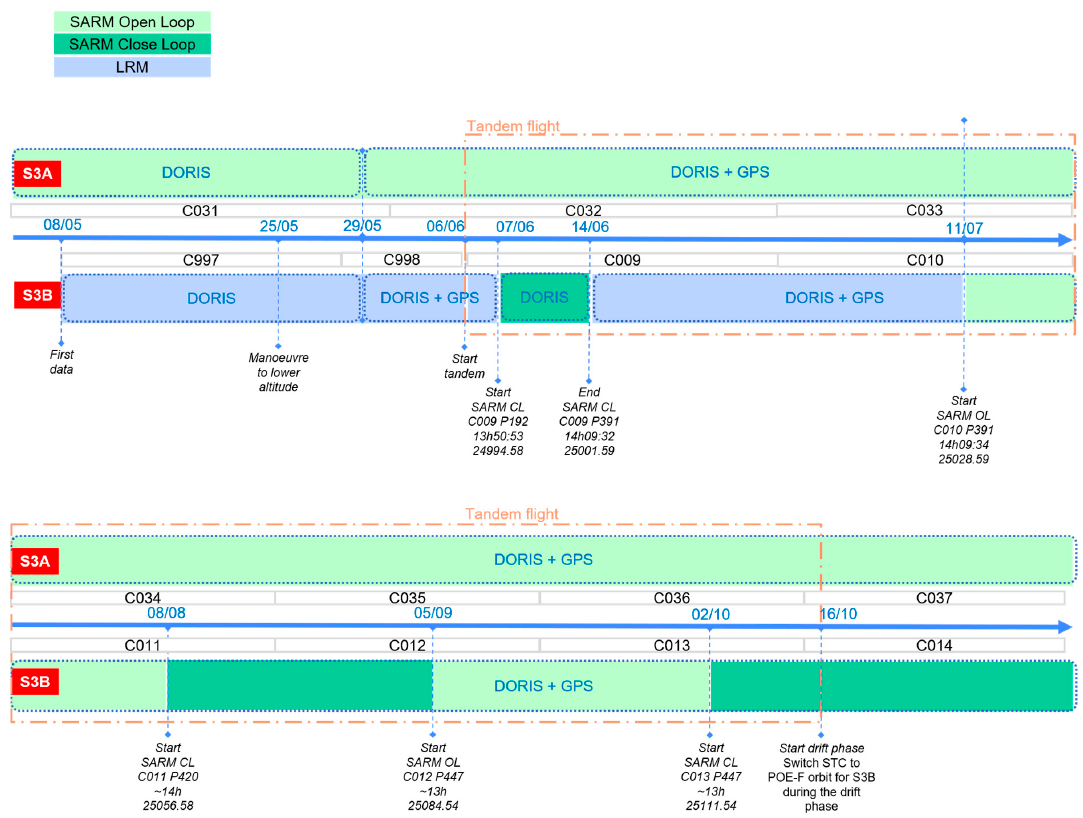
Figure 1. The main phases of the Sentinel-3B tandem operations.